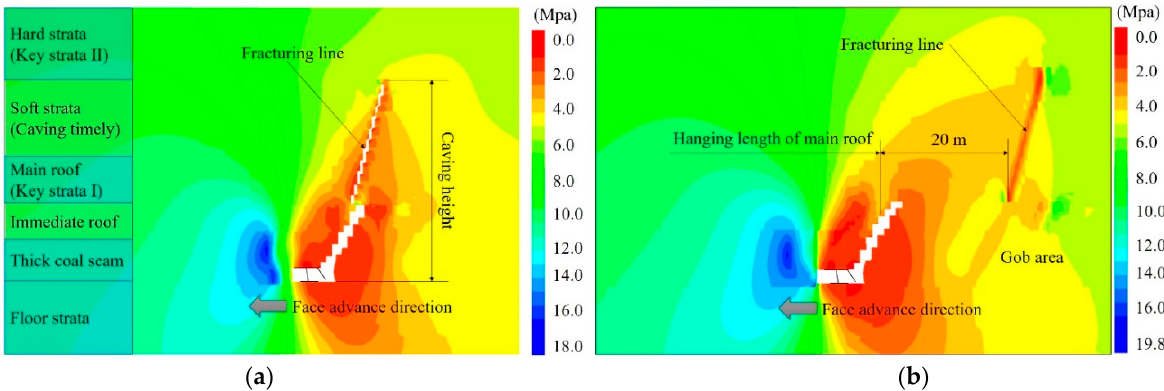
Figure 13. The influence of roof hanging length on abutment stress distribution. ( a ) periodic rupture of the main roof; ( b ) the limit hanging length of the main roof.